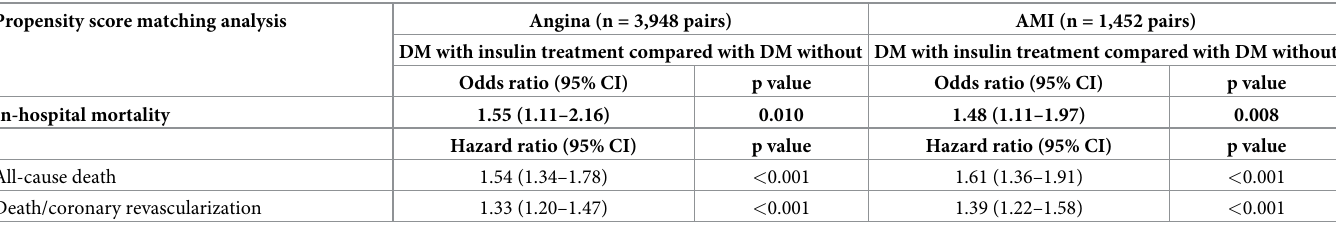
AMI = acute myocardial infarction; CI = confidence interval; DM = diabetes